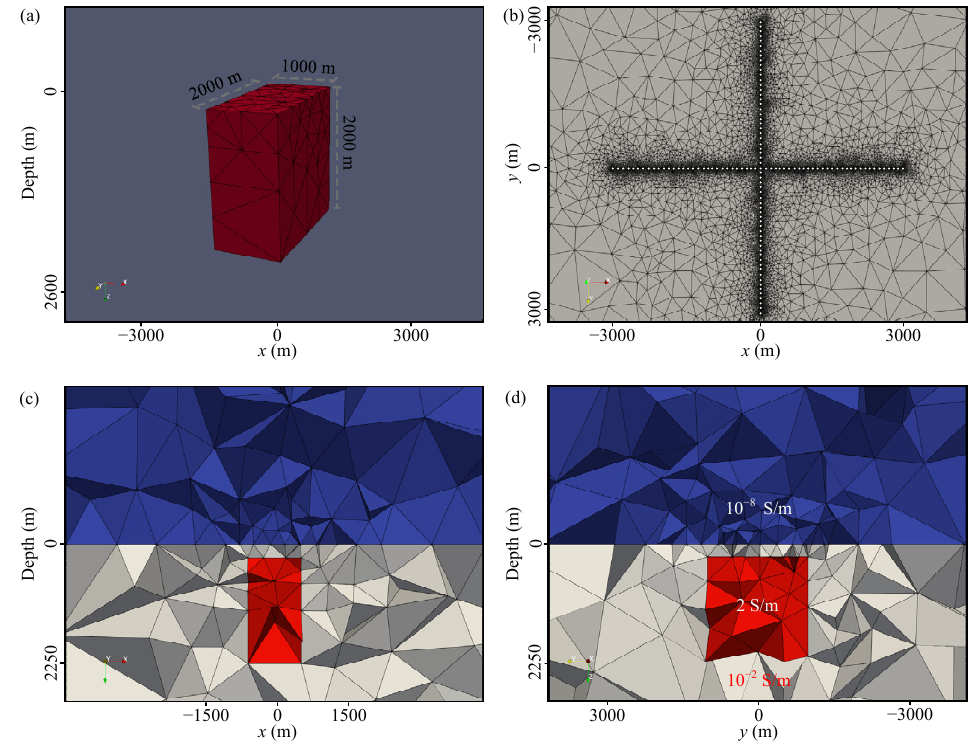
Figure 2. The tetrahedral grids of the COMMEMI 3D-1A model [23]. ( a ) The bird’s-eye view of the conductive block. ( b ) The plane view at z = 0 m, with the white points denoting the observation points. ( c ) The section view at y = 0 m. ( d ) The section view at x = 0 m.